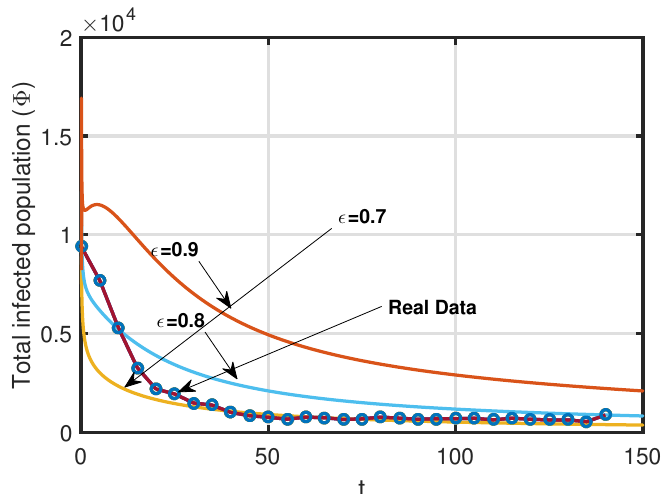
Figure 3. Real Data vs. Model Data of total infected ( I + C ) cases between 1 June 2021 and 20 October 2021.